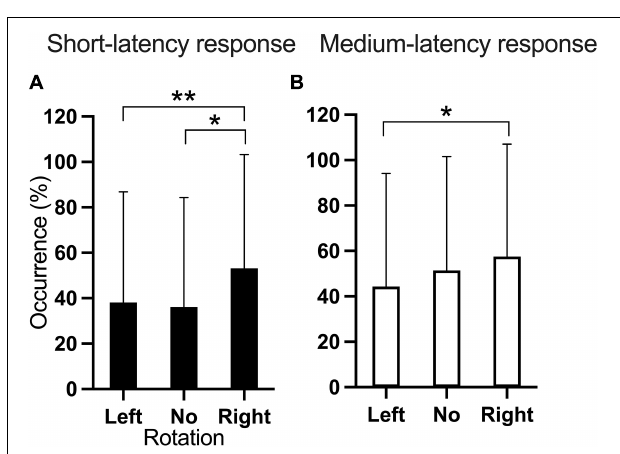
FIGURE 5 | Occurrence of the (A) short- and (B) medium-latency responses according to head rotation. * p < 0.05; ** p < 0.01.